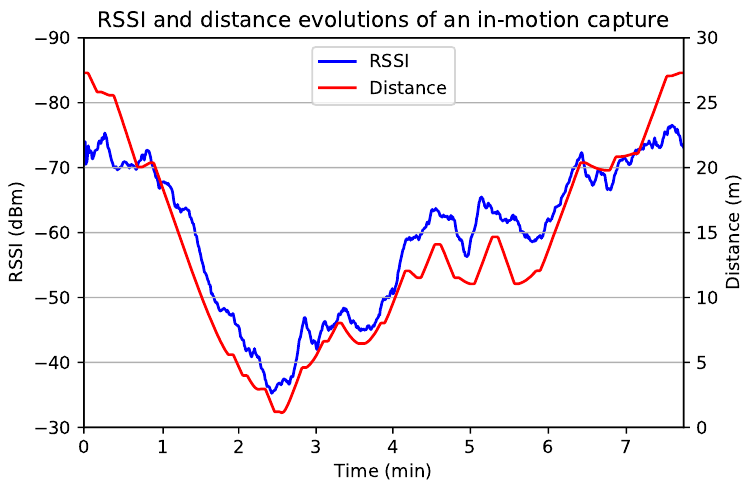
Figure 2. Received signal strength indicator (RSSI) and distance evolutions of a in-motion